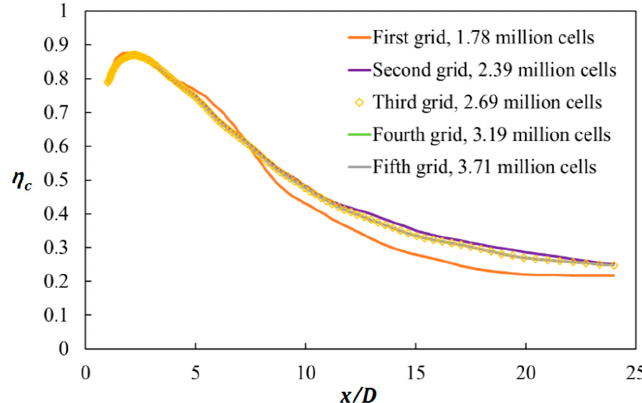
Processes 2020 , 8 , x FOR PEER REVIEW Figure 7. Grid sensitivity test of the large eddy simulation (LES) calculation in the single-hole system. Table 2. Specifications of mesh arrangements in the grid sensitivity test of the single-hole system.